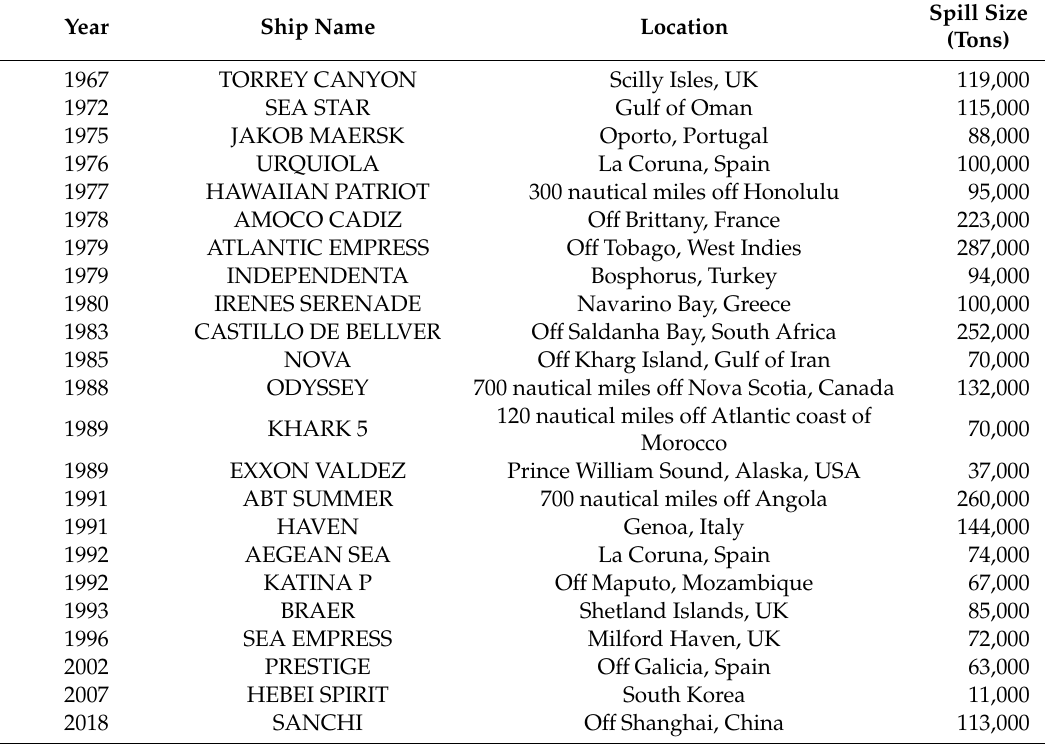
Table 1. Major oil spills since 1967 (quantities rounded to the nearest